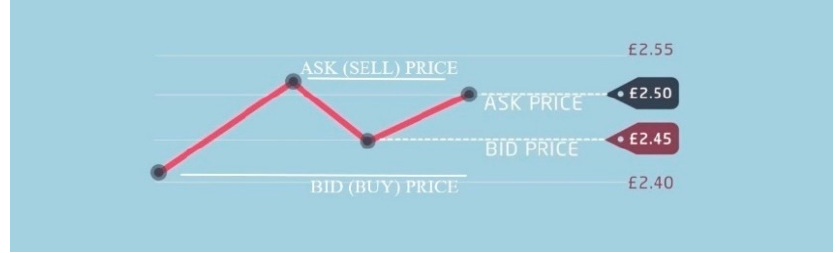
Figure 3. Make a profit between the bid and ask price difference.